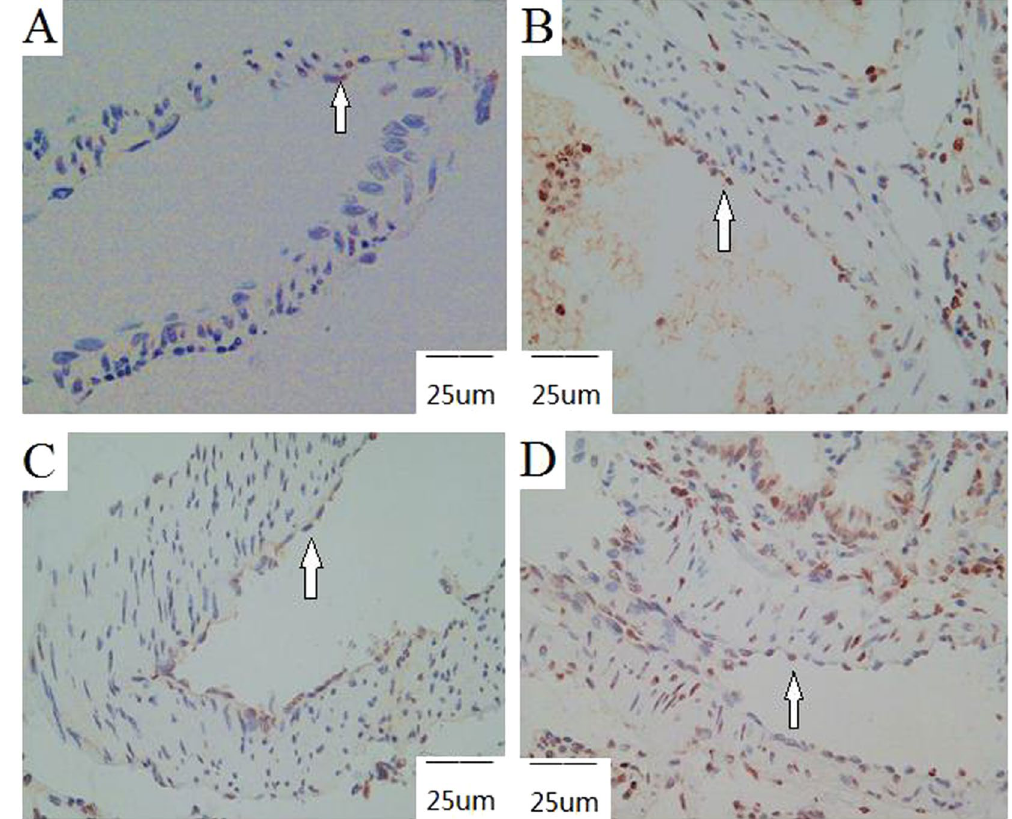
Figure 3. Endothelial cell apoptosis detected by TUNEL in the rat CTEPH model. Note: Apoptotic cells (white arrows). The endothelial cell apoptotic activity of the sham group was the lowest ( A ). In the experimental group, these cells’ apoptotic activity decreased with the prolongation of time ( B–D ).